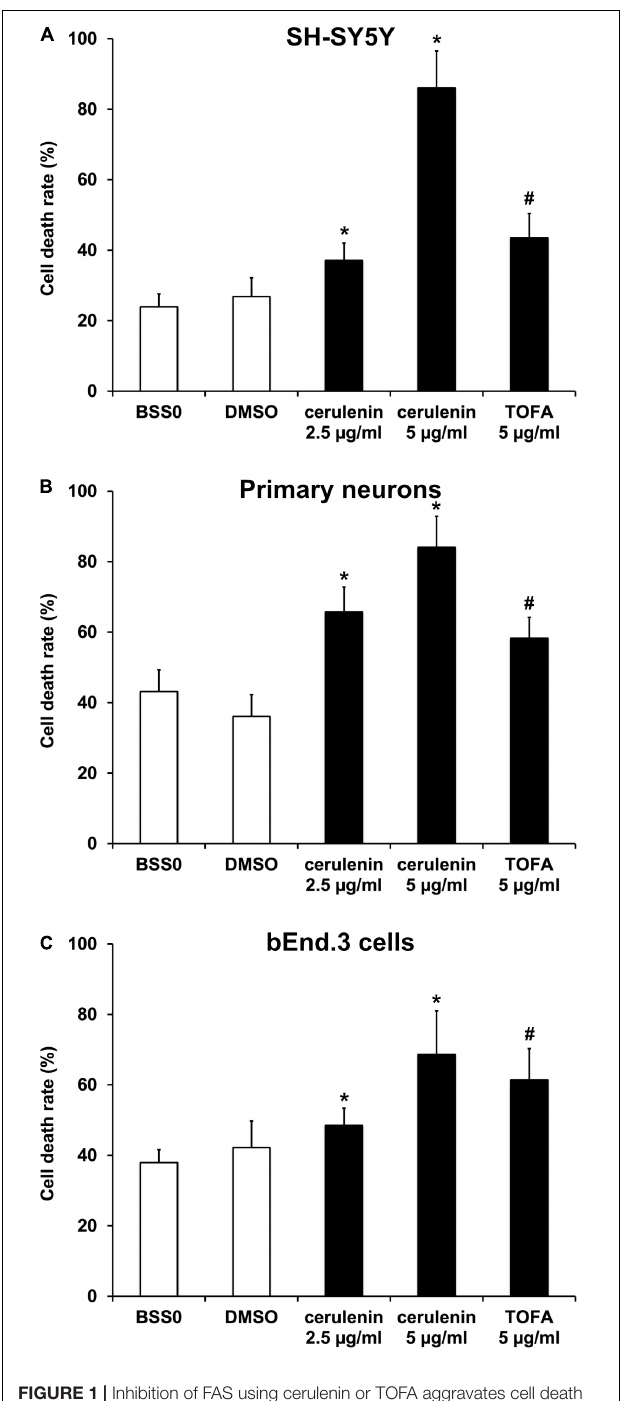
FIGURE 1 | Inhibition of FAS using cerulenin or TOFA aggravates cell death upon induction of oxygen-glucose-deprivation (OGD) in vitro . (A) Cultivated SH-SY5Y cells, (B) primary cortex cells, and (C) bEnd.3 cells were exposed to OGD and FAS inhibition by either cerulenin or TOFA ( n = 4 per condition). The cells were exposed to OGD in BSS0 solution for 10 h (A,B) or 16 h (C) followed by reoxygenation for 24 h under standard cell culture conditions. BSS0 served as control for TOFA, whereas cerulenin was dissolved in DMSO for which the latter served as control. The cell viability was analyzed using the MTT assay. # Significantly different from BSS0 control, p < 0.05. *Significantly different from DMSO control, p <